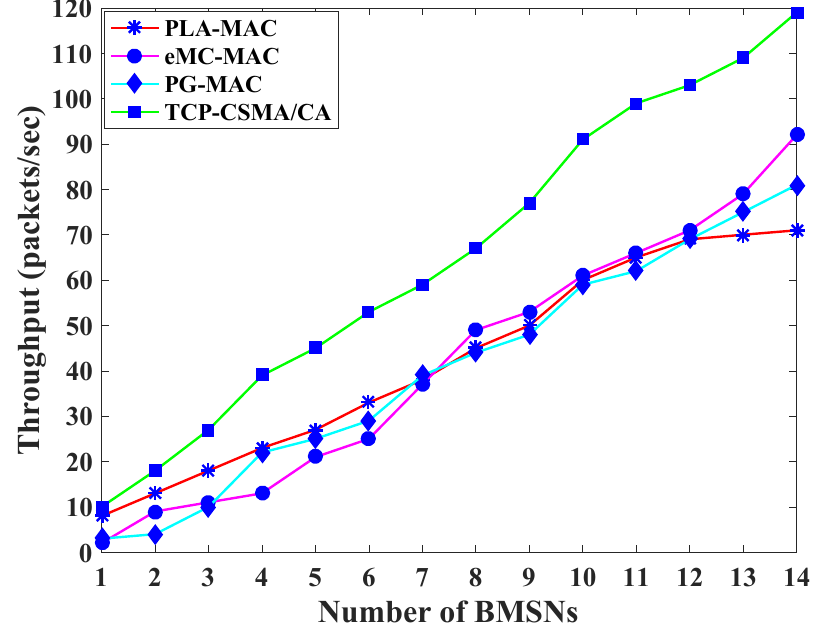
Figure 3. Throughput versus number of BMSNs.